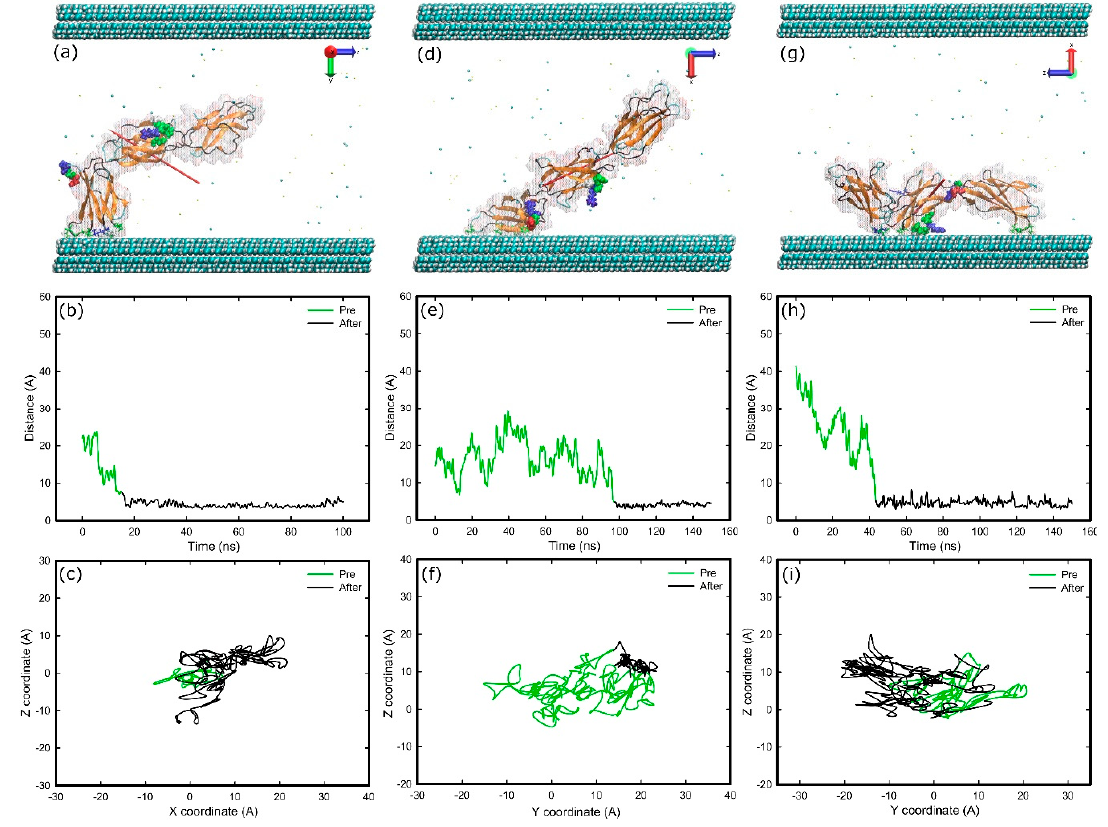
Figure 6. Adsorption of FNIII 8-10 on methyl surfaces in three different orientations; ( a – c ) “head-on”; ( d – f ) “beta-on”; and ( g – i ) “side-on”. ( a , d , g ) Snapshots at the end of simulation, ( b , e , h ) distance of the anchoring residues perpendicular to the surfaces over time, ( c , f , i ) diffusion of the anchoring residues over the surface. The colour-coding is the same as Figure 1.